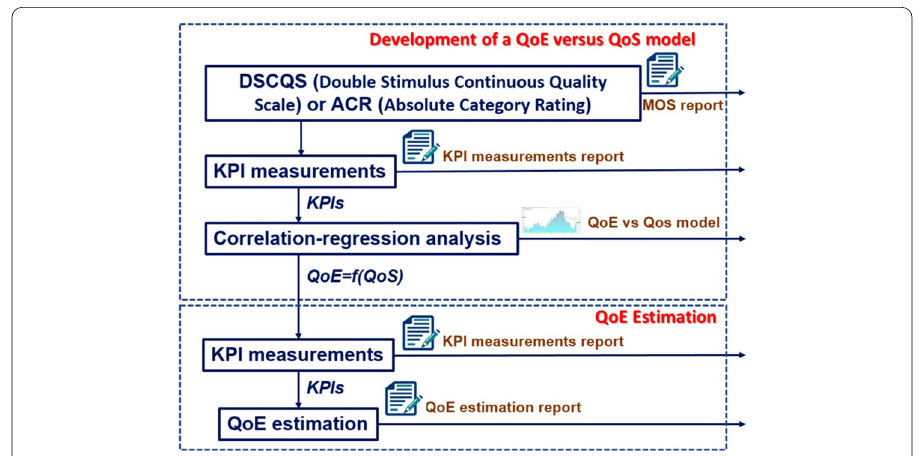
Fig. 3 Estimation method of QoE based on KPI measurements